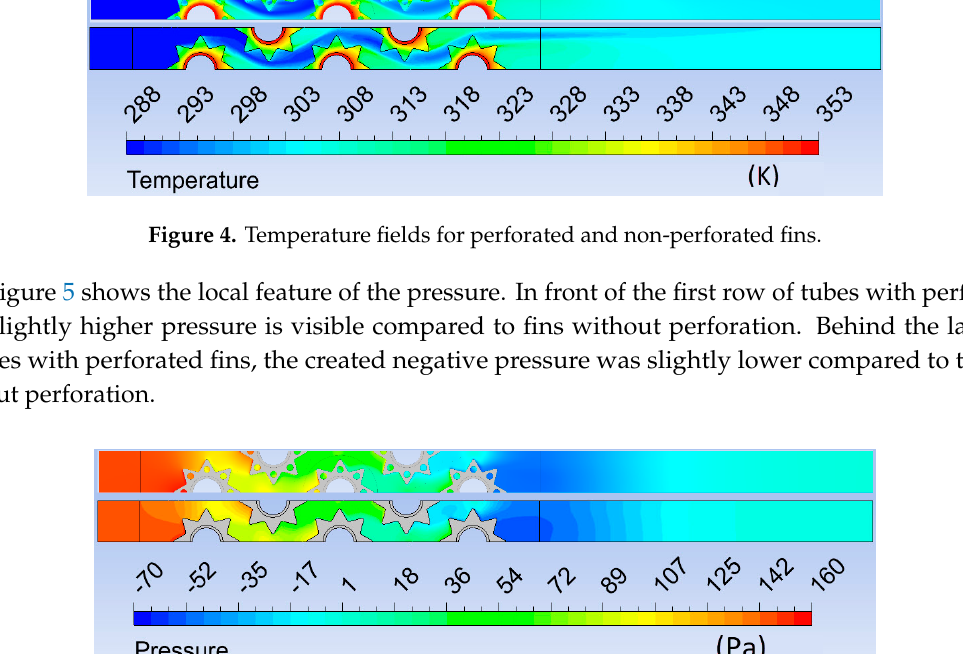
Figure 5. Pressure fields for perforated and non ‐ perforated fins.